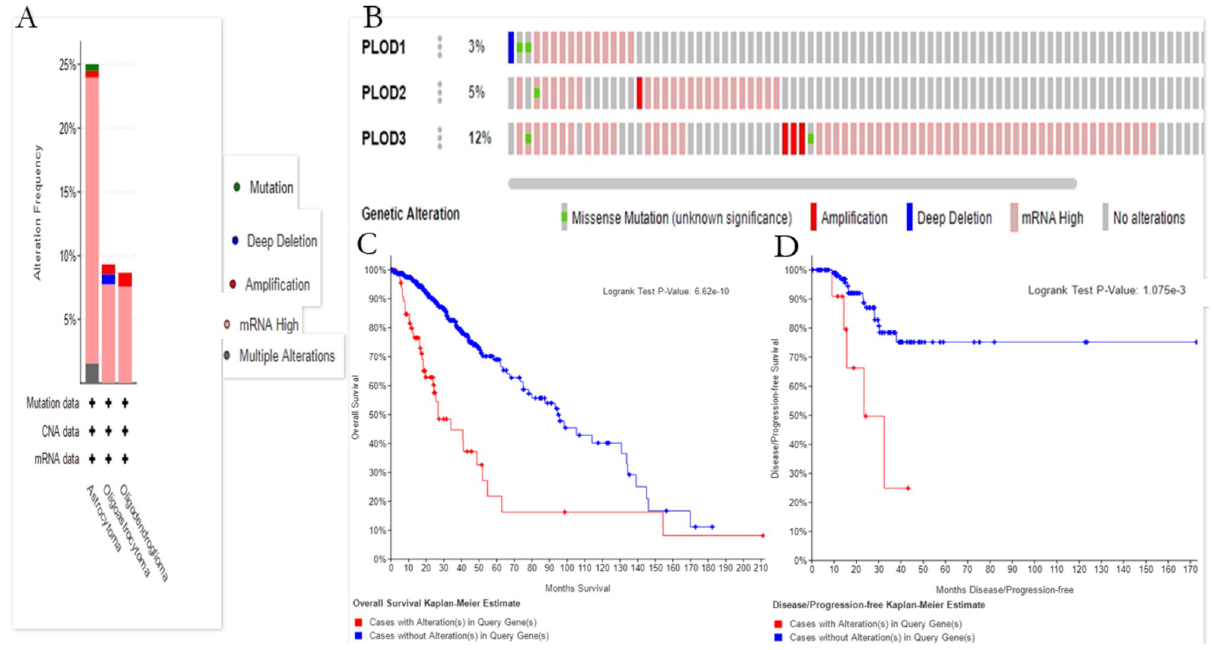
Fig 3. Alteration frequency and prognosis of the PLOD family genes in patients with LGG. (A) The summary of the cancer types in the cBioPortal was used to calculate the percentages of LGG cases with of the PLOD family genes. (B) mRNA expression alterations (RNA Seq V2 RSEM) of the PLOD family genes in LGG patients. (C) OS and DFS/PFS of LGG patients with altered (red) and unaltered (blue) mRNA expression of the PLOD family genes. The red curves in the Kaplan-Meier plots includes all tumors with PLOD1/2/3 germline or somatic mutation, the blue curves include all samples without PLOD1/2/3